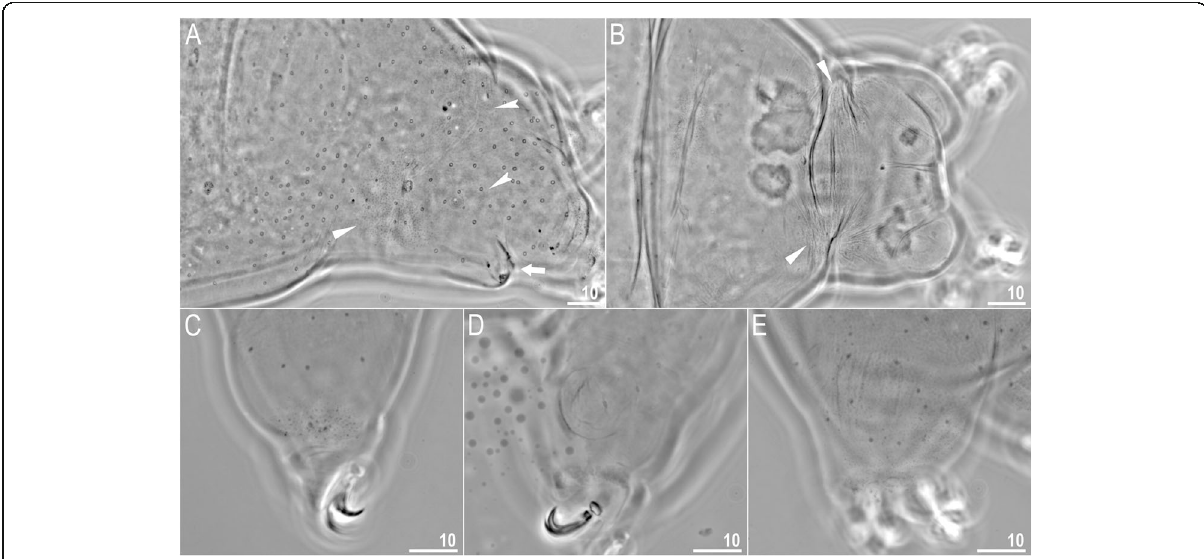
Fig. 4 Macrobiotus pallarii Maucci, 1954 from the topotypic population (IT.337) – body and leg cuticle morphology seen with LCM: a – b – band of caudal granulation on the last body segment clearly visible in specimen with stretched cuticle (A) and hardly visible in specimen with wrinkled cuticle ( b ); c – granulation on the external surface of leg III; d – internal surface of leg III with evident pulvinus; e – granulation on dorsal surface of leg IV. Filled flat arrowheads indicate dense patches of granulation in the caudal band, filled indented arrowheads indicate sparse granulation in the caudal band, arrow indicates lateral gibbosity on the IV leg – a male secondary sexual character. Scale bar in μ